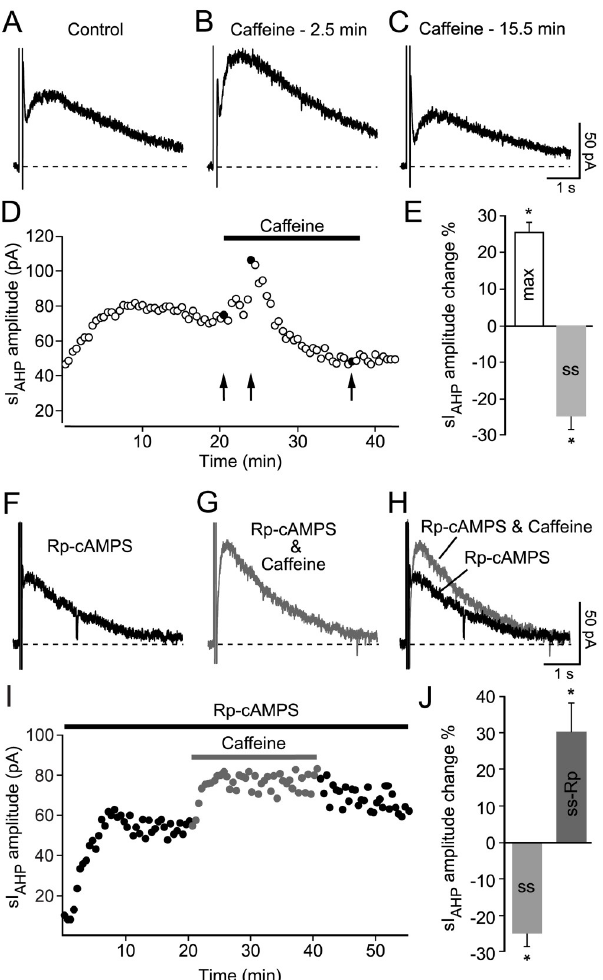
Fig 1. Effect of caffeine on sI AHP in rat CA1 neurons. (A) Representative sI AHP trace at steady state. (B) sI AHP trace maximally enhanced after 2.5 min into the application of caffeine (0.5 mM). (C) sI AHP reduction after continuous application of caffeine. (D) Time course of action of caffeine (0.5 mM) on the sI AHP amplitude. Data point in black and indicated by arrows correspond to traces (A-C) . (E) Summary bar diagram, showing that the sI AHP amplitude first increased by 25.3 ± 2.9% ( max : n = 22; P < 0.0001), followed by a decrease by 24.5 ± 3.6% at steady state ( ss : n = 16; P < 0.0001) when compared to the current amplitude preceding caffeine application. (F) Representative sI AHP trace recorded at steady state but with the PKA inhibitor Rp-cAMPS (500 μ M) applied intracellularly. (G) sI AHP current increase in the presence of Rp-cAMPS and after ~17.5 min application of caffeine (0.5 mM), a time point comparable to ( C ). (H) Overlay of the sI AHP traces in F and G . ( I) Time course of action of caffeine (0.5 mM) in the presence of Rp- cAMPS; ( ss-Rp ) indicates the trace shown in G . (J) Bar diagram comparing the relative (%) changes in sI AHP amplitude in response to caffeine application at steady state in the absence ( ss ; of panel E ) and presence of the PKA inhibitor Rp-cAMPS ( ss-Rp ). sI AHP amplitude increased by 29.8 ± 7.9% ( ss-Rp : n = 4; P = 0.03) in the presence of Rp- cAMPS after caffeine application when compared to the sI AHP current amplitude preceding caffeine application. The difference between the effect of caffeine with or without Rp-cAMPS is highly significant (P < 10 − 6 ).